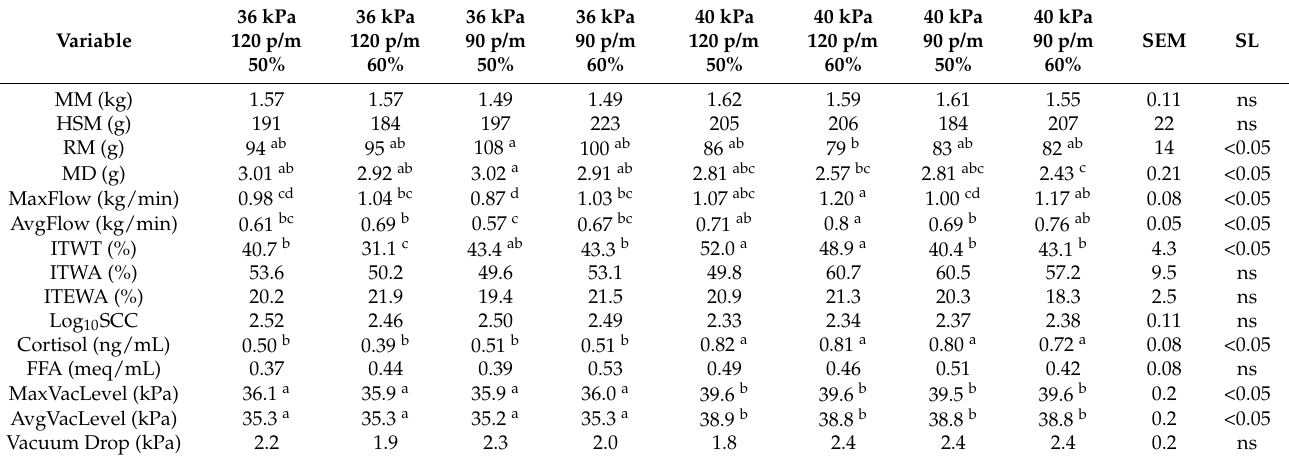
Table 2. Effect of the treatment (combinations of system vacuum, pulsation rate and pulsator ratio) on variables related to milking fractioning, milking efficiency, teat end status, milk composition, animal welfare and vacuum measured in the short milk tube in Murciano-Granadina goats milked in low-line pipes (least square means ± standard error of the